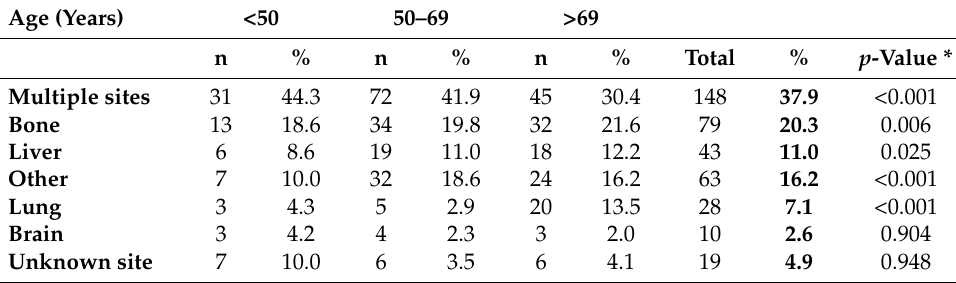
Table 2. Number and proportion of breast cancer patients with single and multiple sites of